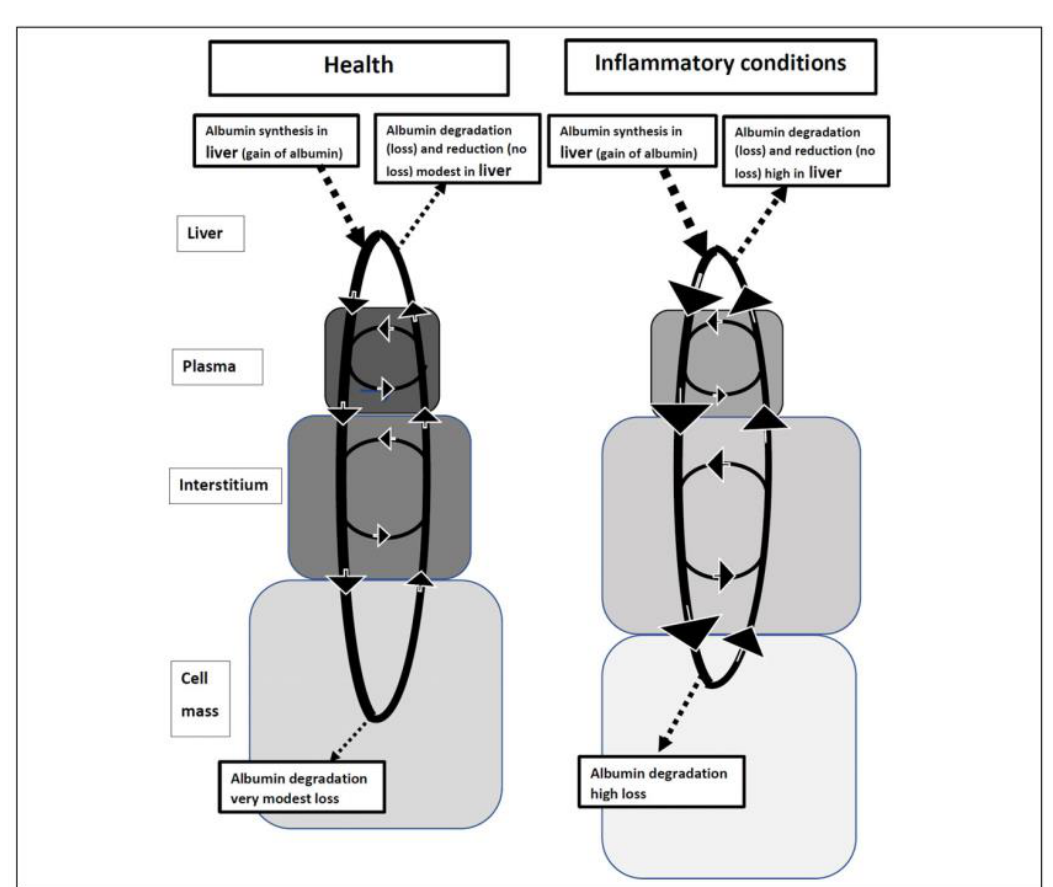
Figure 1. Schematic showing albumin synthesis and degradation in health and inflammatory conditions. Solid arrows represent trans-membrane transport and dashed arrows represent synthesis in the liver. Degradation refers to intracellular proteolysis, Gain to increased total body albumin, Loss to decreased total body albumin, and Reduction to reducing oxidized total body albumin. Reproduced without modification from Soeters et al. 2019 [4], under a Creative Commons Attribution-NonCommercial-NoDerivatives 4.0 International (CC BY-NC-ND 4.0) License (https://creativecommons.org/ licenses/by-nc-nd/4.0/ (accessed on 25 April 2021)). Copyright © 2021 The Authors. This reuse has not been endorsed by the licensor. The source reference is “Hypoalbuminemia: Pathogenesis and Clinical Significance” in JPEN J Parenter Enteral Nutr and is available at https://aspenjournals.onlinelibrary.wiley.com/doi/full/10.1002/jpen.1451 (accessed on 25 April 2021).